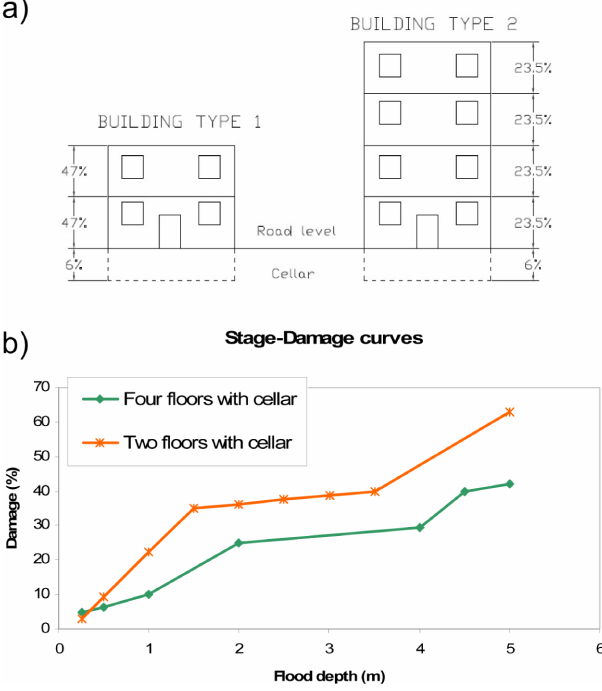
Fig. 9. Reference scheme for the vertical value distribution (a) and structural stage–damage relationships (b) for